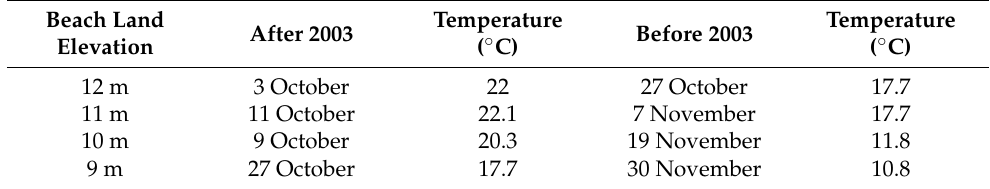
Table 3. Comparison of Exposure Process of 9–12 m Beach Land around 2003. Beach Land Temperature After 2003 Before Elevation ( ◦ C)